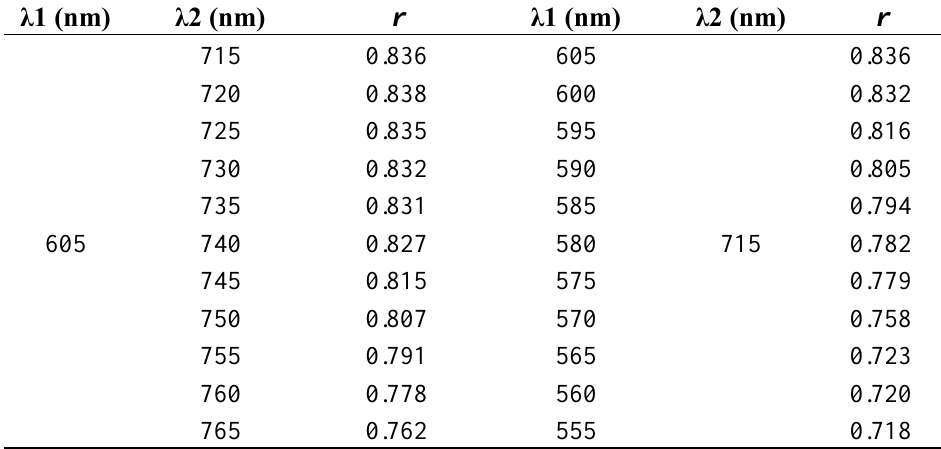
Table 2. Pearson’s correlation coefficient ( r ) between foliar Cu concentrations and S WT (λ1−λ2) with different spectral